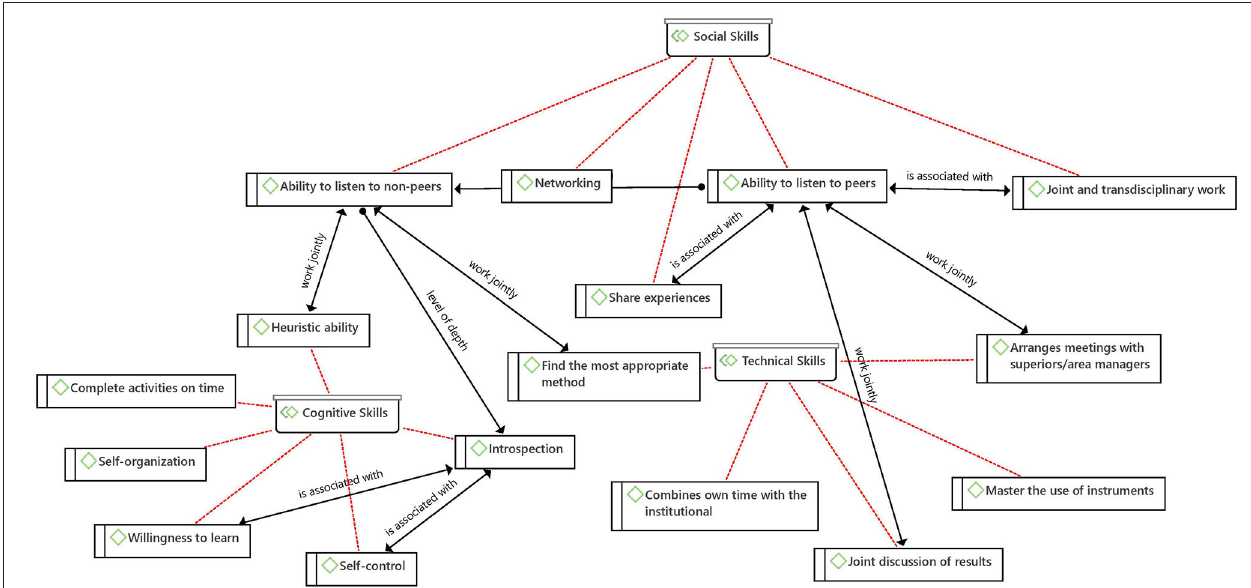
FIGURE 9 | Tacit knowledge